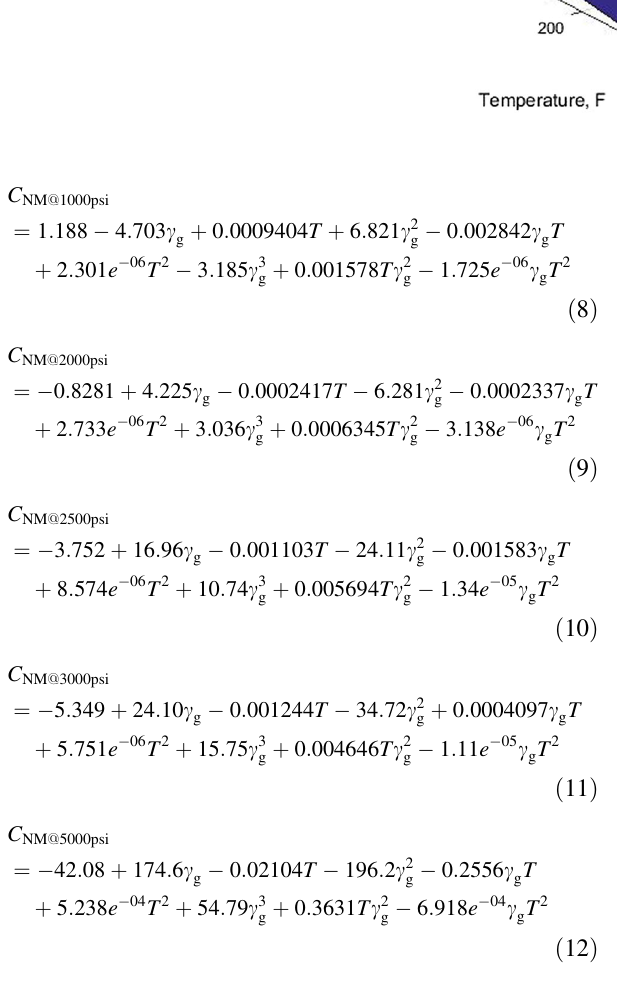
Linear regression techniques in MATLAB have been used to fit the curves presenting polynomial Eqs. 8–12.